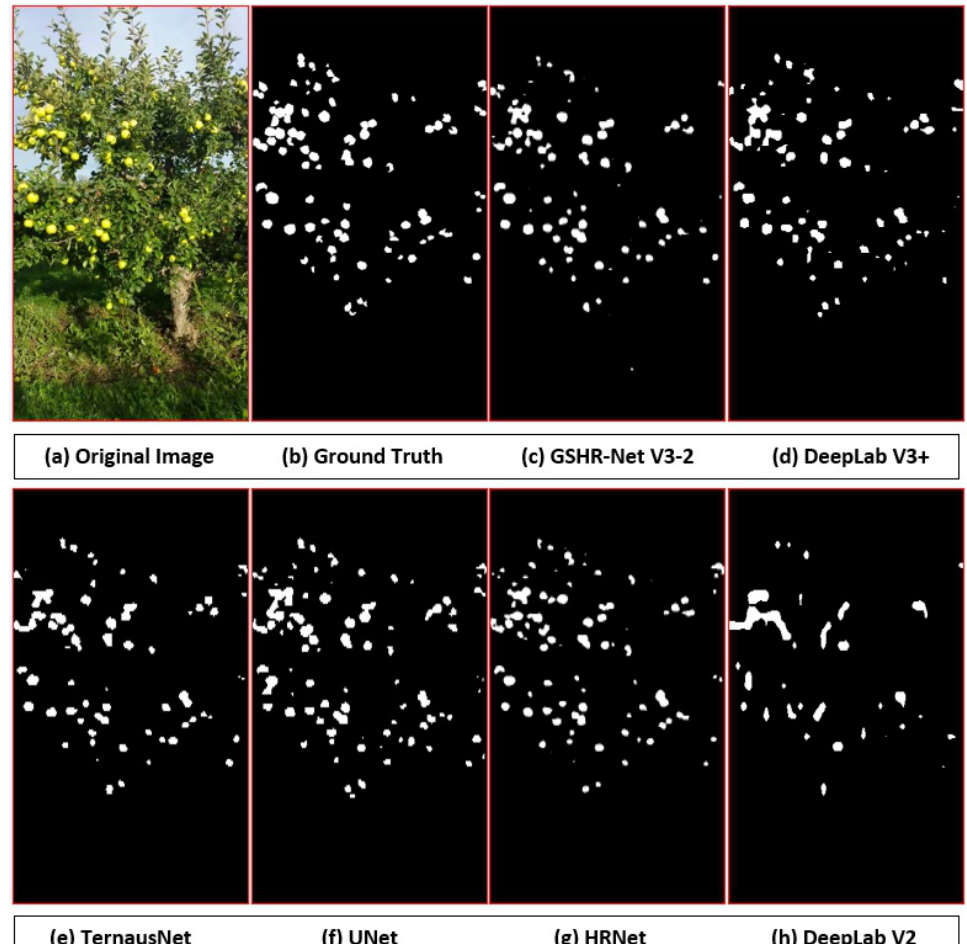
Figure 6. Three variants of group and shuffle operator